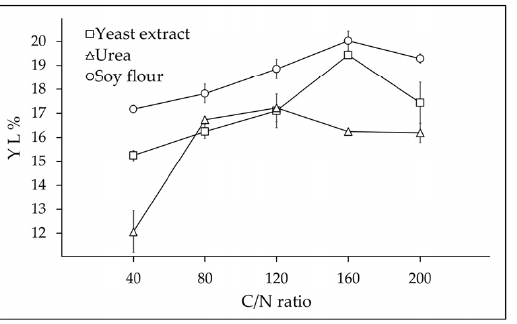
Figure 2. Lipid yield obtained by L. tetrasporus DSM 70314 grown on wheat straw hydrolysate with three different nitrogen sources, Urea, Yeast Extract, and Soy flour, with different C/N